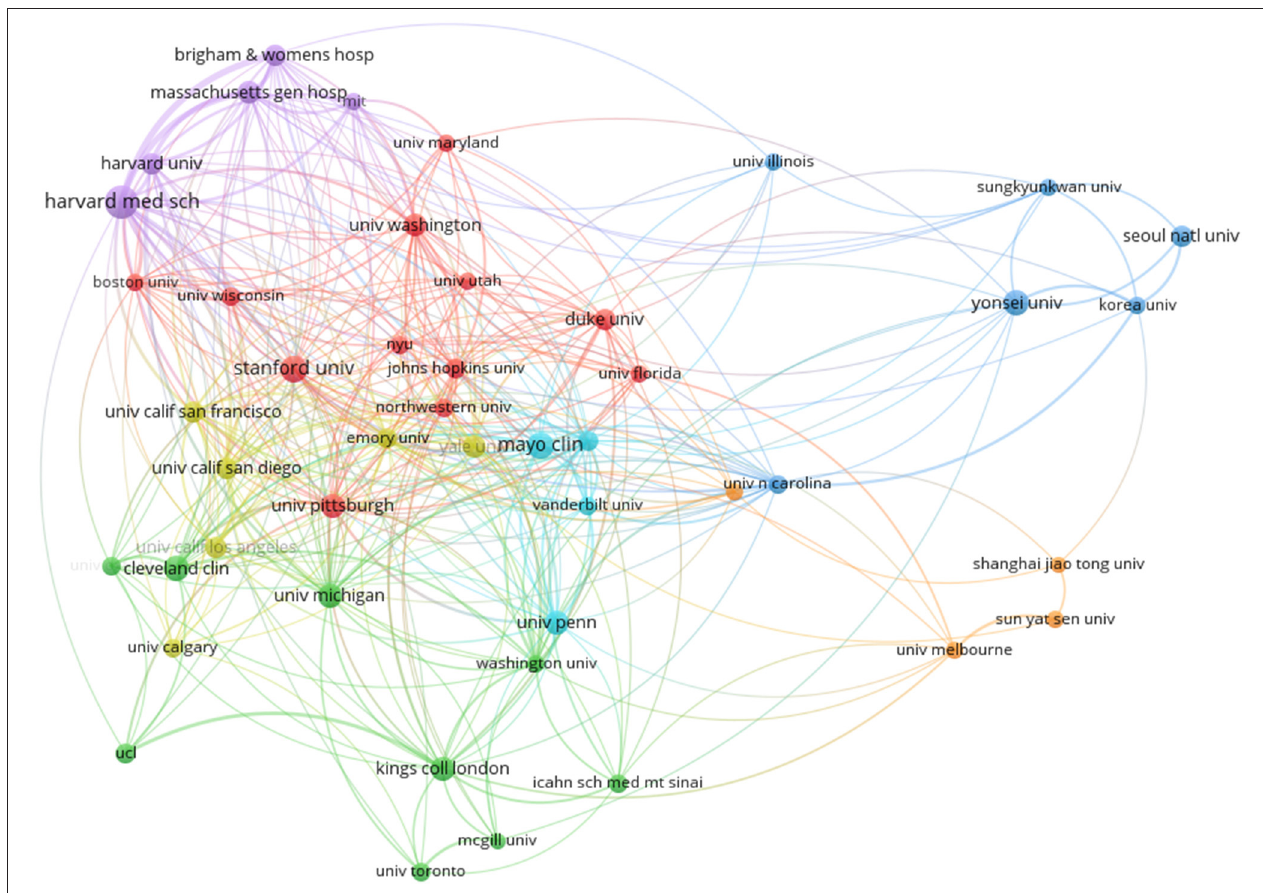
FIGURE 3 | Network visualization map of the